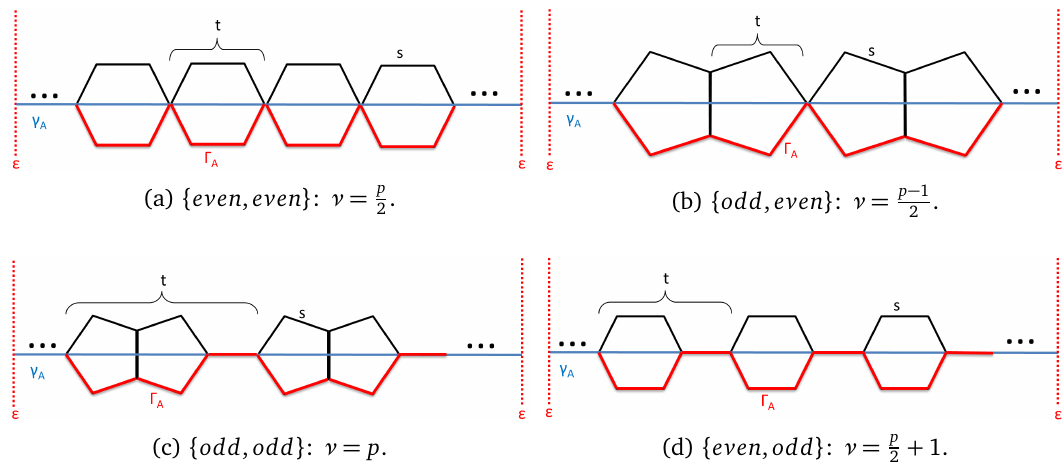
Figure 3: Hyperbolic patterns encompassing repeated segments of length t ( p , q ) of a continuous geodesic γ (blue line) for different parities of { p , q } . We take γ to be A A a diametric geodesic of D 2 here for clarity. Suitable choice of radial cutoff ε guar- antees that the endpoints of γ coincide with vertices of the tiling. A single pattern A contributes a number ν of edges to the discrete path Γ (red line) that approximates A γ A